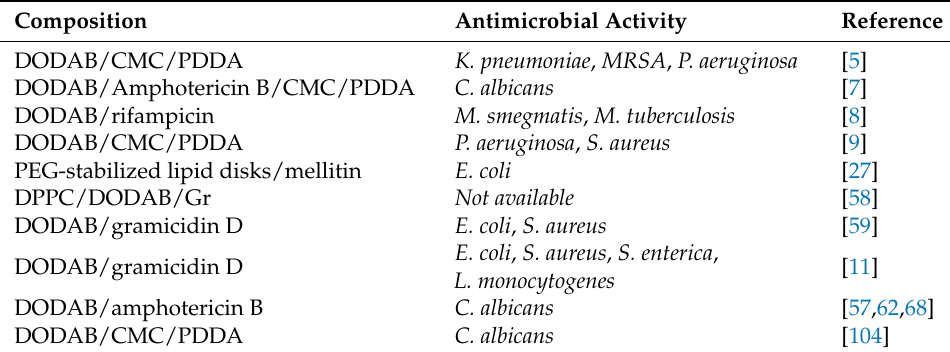
Table 1. Self-assembled nanodisks: composition and antimicrobial activity.